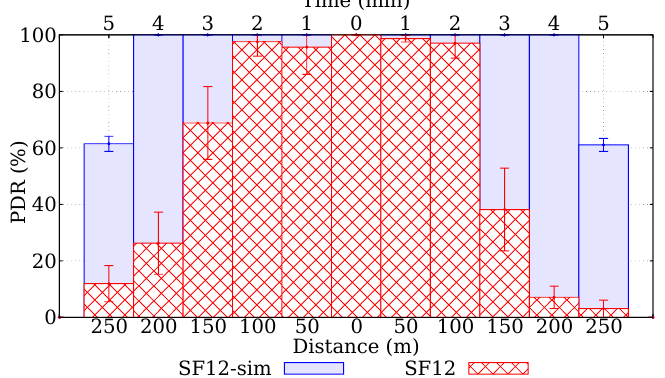
Figure 18. Packet Delivery Ratio (PDR) vs. distance—50m/min—simulated vs. practical.